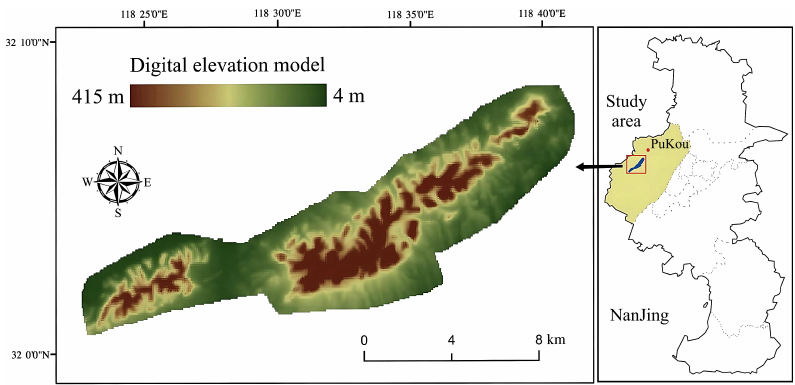
Figure 2. The study